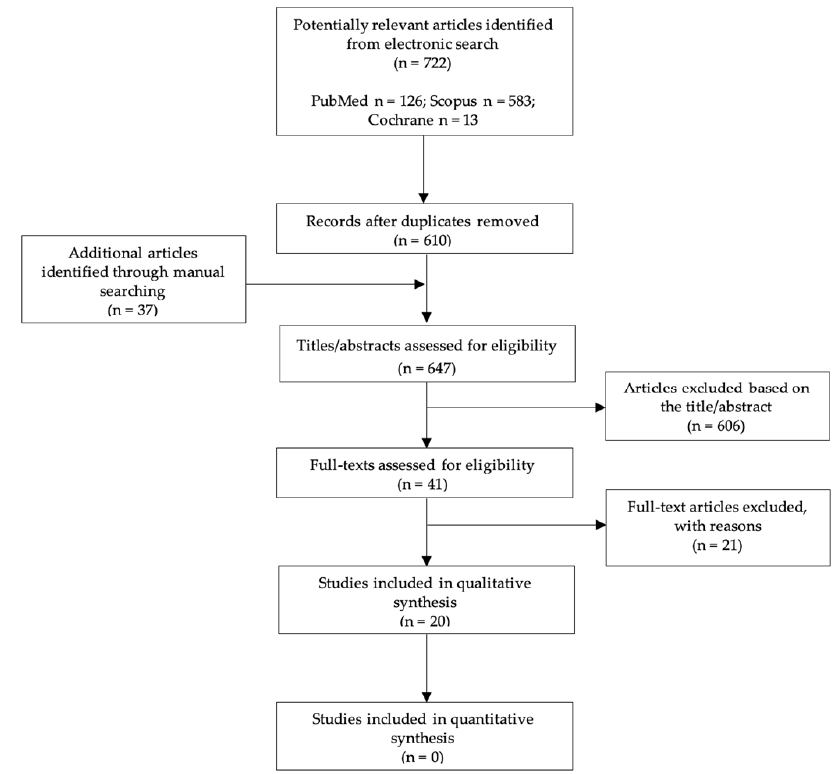
Figure 1. Flowchart of the article selection procedure.